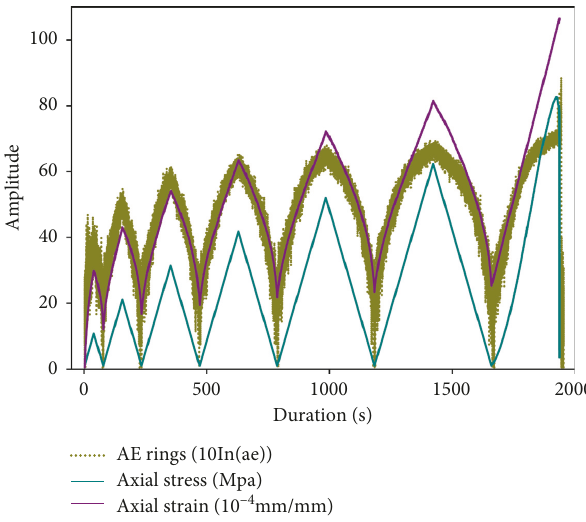
Figure 3: Relationships among the AE rings, axial stress, and strain of 1# red sandstone specimen under the uniaxial cyclic loading and unloading compression. Logarithmic format was applied to the AE counts and the axial strain was magnified 1